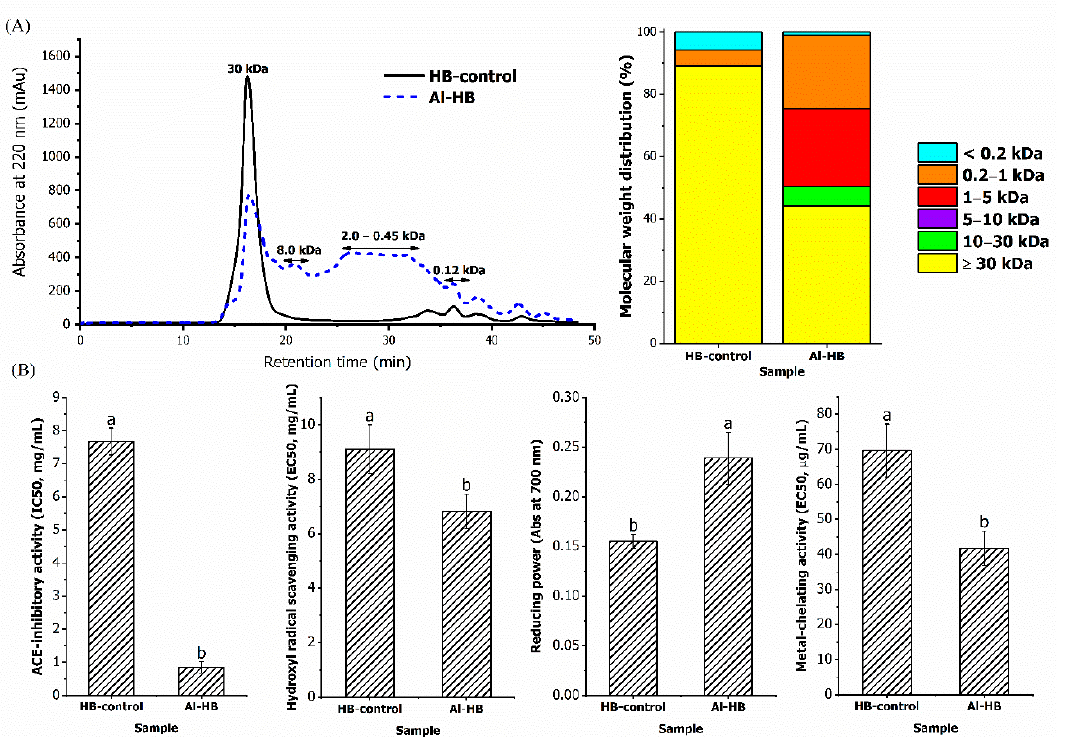
Figure 2. ( A ) The molecular weight distribution of HB ‐ control and Al ‐ HB after passage through a Superdex Peptide 10/300 GL column. ( B ) The ACE ‐ inhibitory and antioxidant activities of the HB ‐ a Superdex Peptide 10/300 GL column. ( B ) The ACE-inhibitory and antioxidant activities of the control and Al ‐ HB. The values represent the mean ± SD. Means without a common letter (a,b) on HB-control and Al-HB. The values represent the mean ± SD. Means without a common letter (a, b) the bars indicate significant difference at p < 0.05. on the bars indicate significant difference at p <